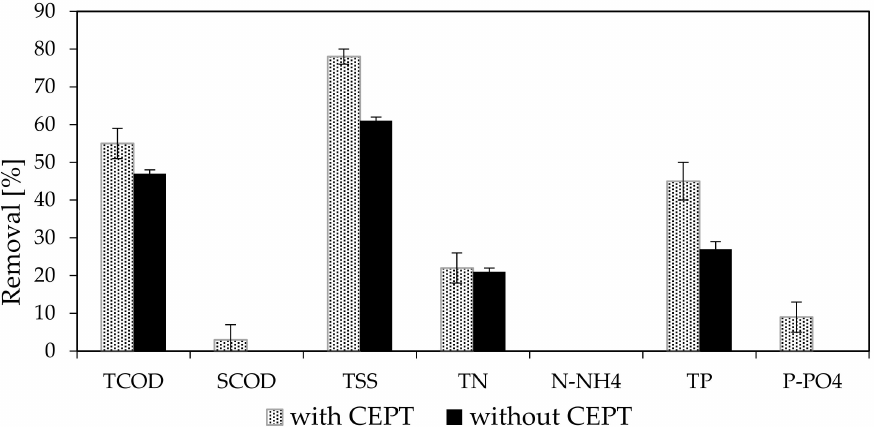
Figure 1. Pilot-scale trials: removal efficiency of total chemical oxygen demand (TCOD), soluble COD (SCOD), total suspended solids (TSS), total nitrogen (TN), the concentration of ammonium (N–NH 4 ), total phosphorus (TP), and phosphates (P–PO 4 ) . A simple sedimentation process resulted in 61%, 47%, 27%, and 21% for TSS, COD, TP, and TN removal, respectively. The achieved results corresponded to the typical removal rate observed in municipal WWTPs [26]. PIX addition caused a noticeable increase